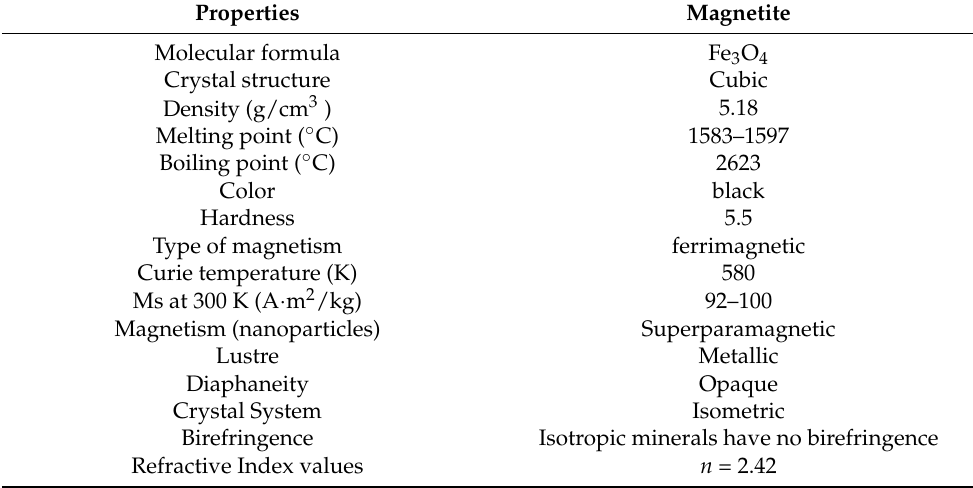
Figure 1. Visualization of the magnetite unit cell identified using octahedral Fe 2.5+ (dark grey), tetrahedral Fe 2+ (light grey), and oxygen (red). The local site symmetries are shown by the octahedral and tetrahedral shapes around fully coordinated Fe sites within the unit cell. The different bond angles between the Fe sites lead to dominant antiferromagnetic coupling between the tetrahedral and octahedral sites, giving a bulk ferrimagnetic order (adapted from [34] with permission from Springer Nature). Table 1. Properties of